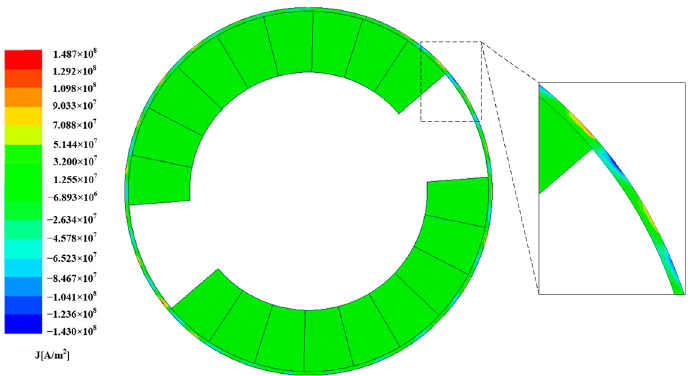
Figure 17. The eddy current density distribution of the 1 mm carbon fiber jacket.